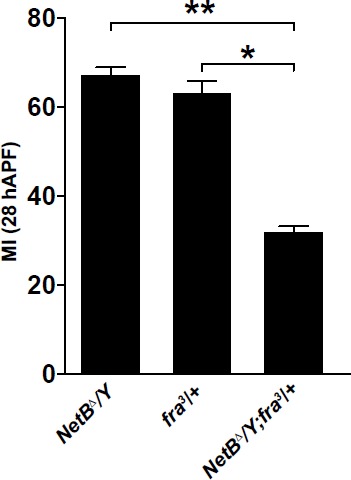
DOI:
http://dx.doi.org/10.7554/eLife.15983.031